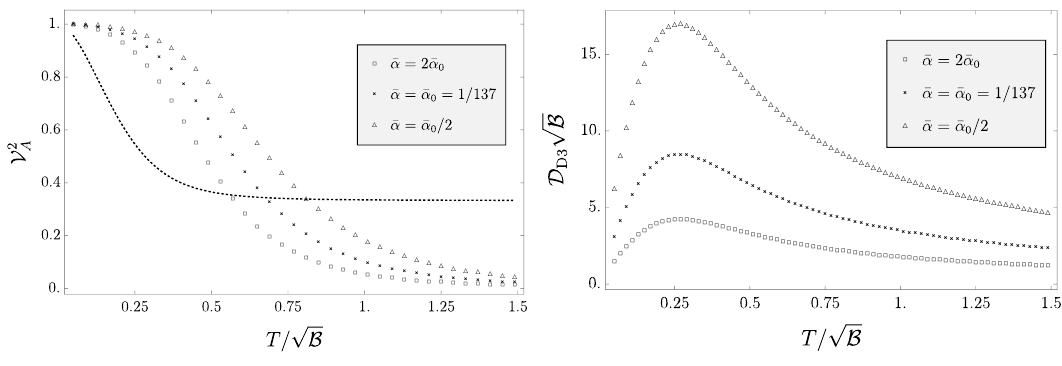
Figure 11 . The plot of V 2 and the di(cid:11)usion constant D D 3 at (cid:22) (cid:11) = f (cid:22) (cid:11) 0 = 2 ; (cid:22) (cid:11) 0 ; 2(cid:22) (cid:11) 0 g , where (cid:22) (cid:11) 0 = A 1 = 137. The dashed line in the left plot is the (cid:22) (cid:11) -independent speed (squared) of the S3 mode (cf. (cid:12)gure 4), i.e. V 2 , which is plotted for comparison. 0